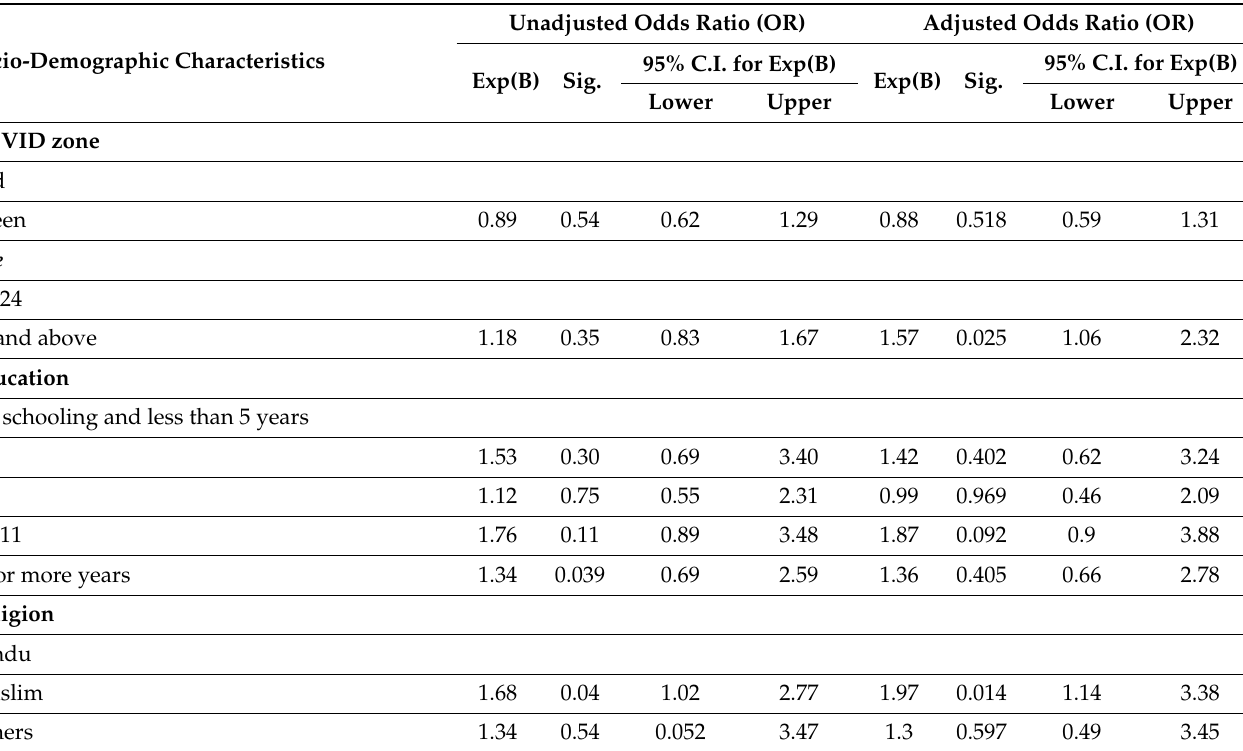
Table 2. Unadjusted and adjusted odds ratios and confidence intervals with respect to possible risk factors related to the challenges faced by the patients in accessing MCH services during lockdown.